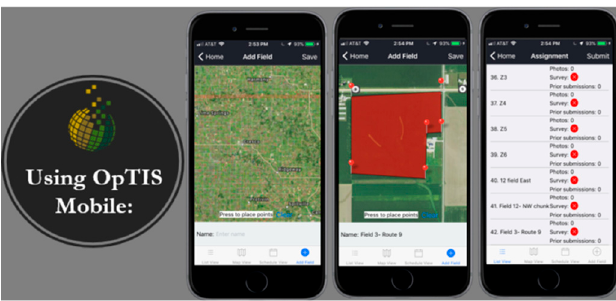
Figure 3. Schematic for identifying and drawing an agricultural field in the OpTIS mobile map screen.